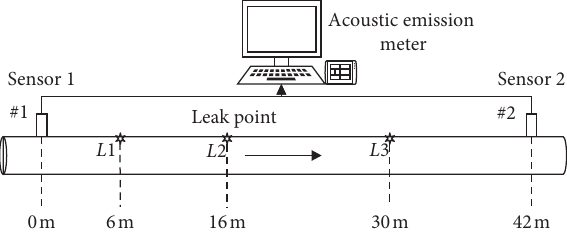
Figure 3: Test pipeline leakage location diagram.